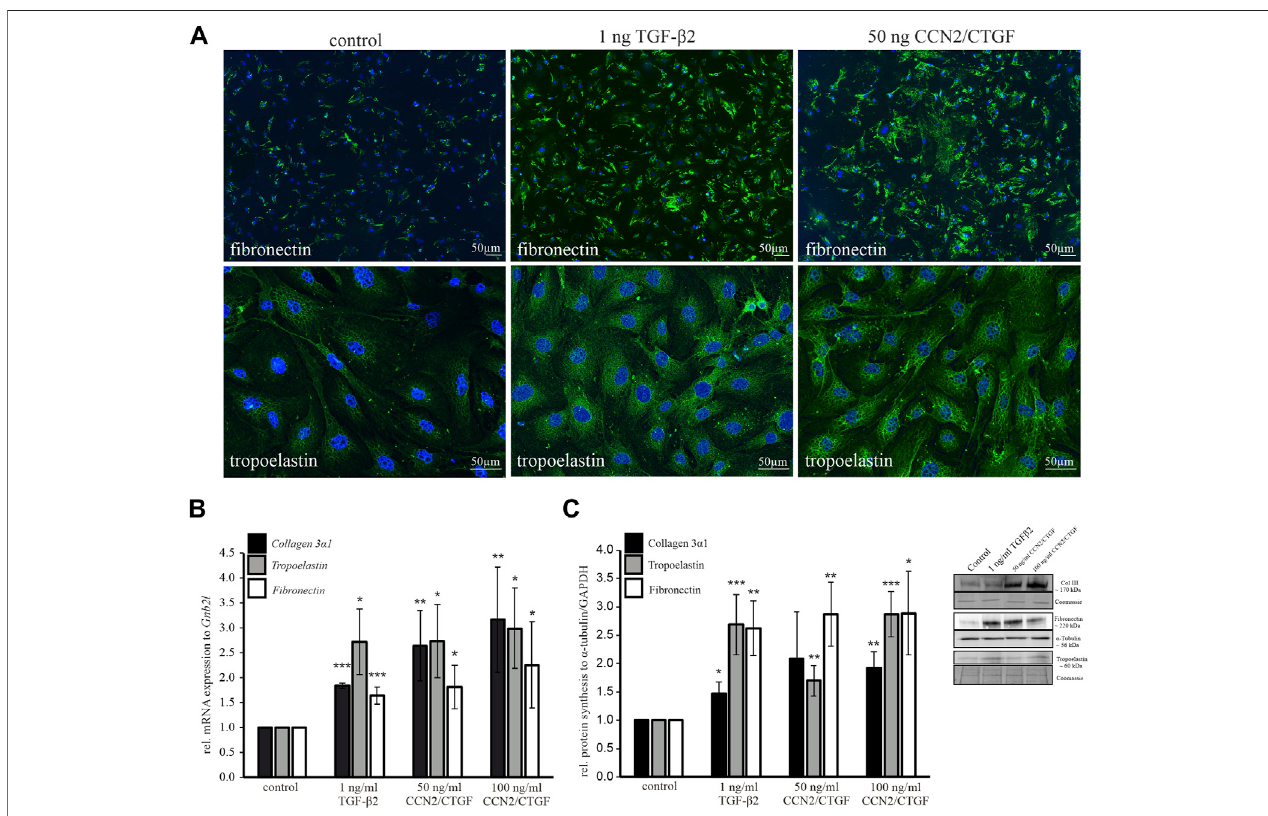
FIGURE 6 | Analyses of ECM components in murine ON astrocytes following treatment with TGF- β 2 and CCN2/CTGF. (A) Immunocytochemical staining against fi bronectin (green, upper panel) showed a markedly increase following the treatment with 1 ng/ml TGF- β 2 or 50 ng/ml CCN2/CTGF. Immunocytochemical staining against tropoelastin (green, lower panel) showed a pronounced increase after the treatment with 1 ng/ml TGF- β 2 or 50 ng/ml CCN2/CTGF. Nuclei were stained with Dapi (blue). (B) Real-time RT-PCR analyses shows an intense upregulation of collagen 3 α 1 , tropoelastin and fi bronectin mRNA in murine ON astrocytes after treatment with 1 ng/ml TGF- β 2, 50 ng/ml CCN2/CTGF or 100 ng/ml CCN2/CTGF for 24 h compared to untreated control cells ( collagen 3 α 1 : n = 3; TGF- β 2 *** p = 0.0000004, 50 ngCTGF ** p = 0.005, 100ngCTGF ** p = 0.008; fi bronectin : n = 6, TGF- β 2 * p = 0.00004, 50 ng CTGF * p = 0.016, 100 ngCTGF * p = 0.05; elastin : n = 5, TGF- β 2 * p = 0.026, 50 ng CTGF *0.04, 100 ng CTGF * p = 0.03). mRNA expression was normalized to Gnb2l and mean value of control cells was set at 1. (C) Western Blotanalysisshowanincreaseinproteinsynthesisofcollagen3 α 1,elastinand fi bronectininmurineONastrocytesaftertreatmentwith1 ng/mlTGF- β 2,50 ng/mlCCN2/ CTGFor 100 ng/ml CCN2/CTGFfor 24 hcomparedtountreatedcontrol cells (collagen 3 α 1: n = 3,TGF- β 2 * p =0.03, 100 ngCTGF** p =0.009; fi bronectin: n =5, ** p = 0.005,50 ngCTGF ** p = 0.006, 100 ngCTGF* p = 0.02; tropoelastin: n =5, TGF- β 2*** p =0.0004,50 ngCTGF ** p =0.002,100 ngCTGF *** p =0.00001). GAPDHand α -tubulin were used to normalize protein synthesis and mean value of control cells was set at 1. Right panel shows representative Western Blots for all three proteins. Data represented as mean ± SD.